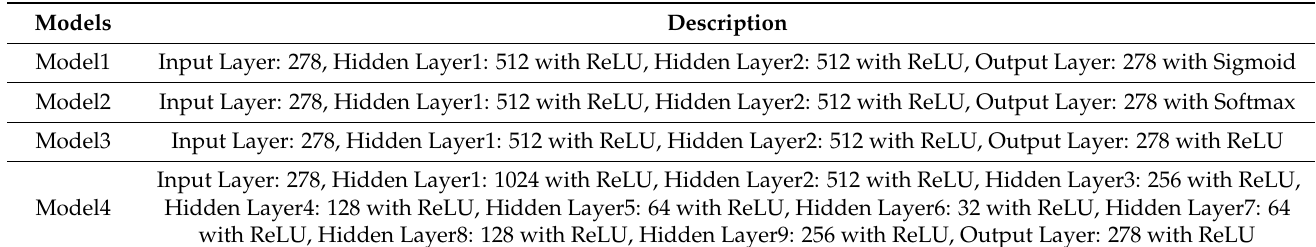
Table 1. Summarization of machine learning and deep learning